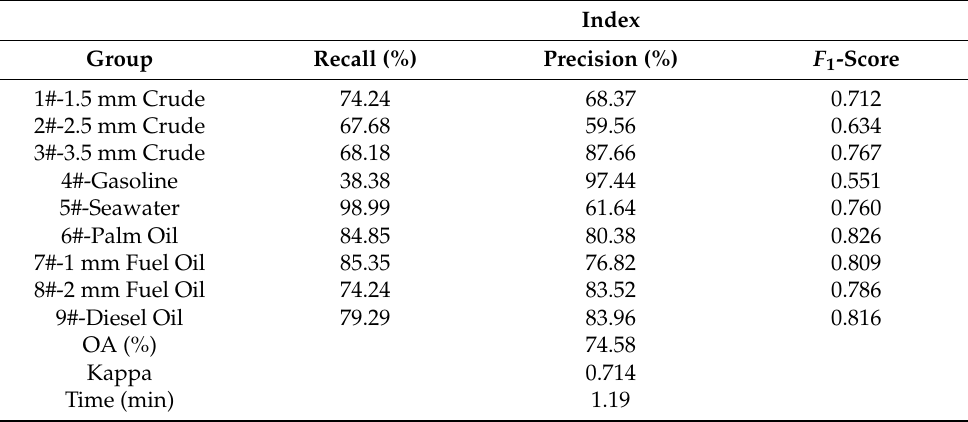
Table 14. Accuracy of thermal infrared oil spill detection based on